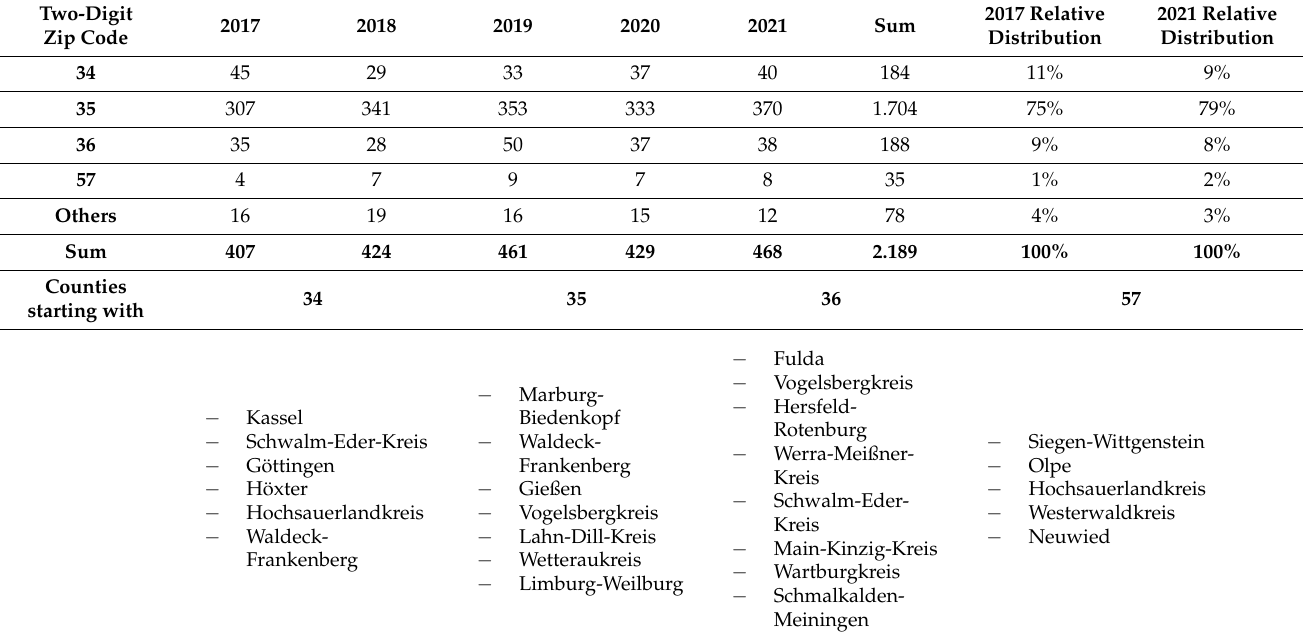
Table 2. C50 frequency distribution by two-digit zip